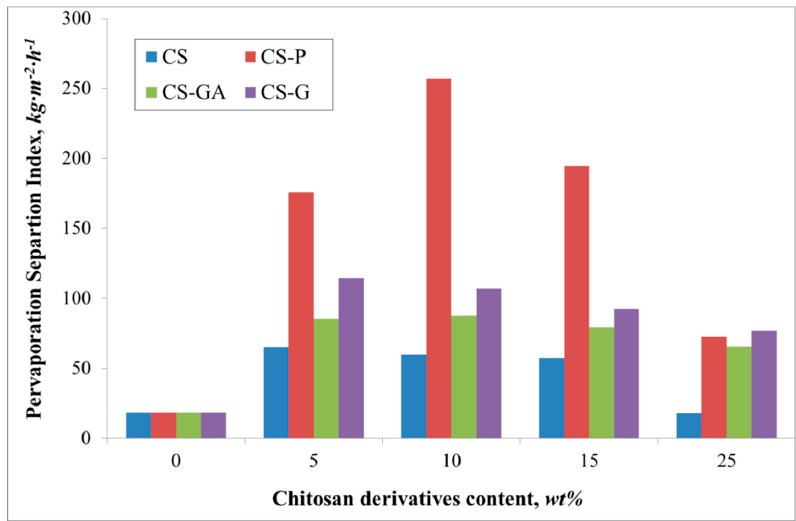
Figure 6. The variation of the measured total Pervaporation Separation Index for Alg membranes with increasing content of chitosan (CS) and modified CS microparticles; phosphorylated chitosan (CS ‐ P), glutaraldehyde crosslinked chitosan (CS ‐ GA), and glycidol ‐ modified chitosan (CS ‐ G).